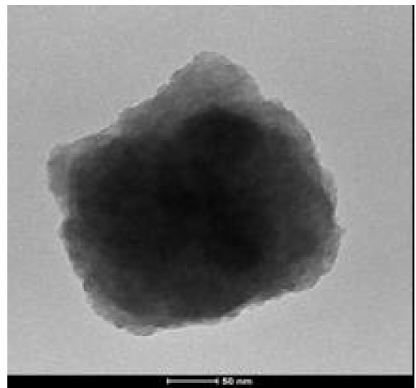
Figure 6. TEM micrograph of a tannic acid template mesoporous silica nanoparticle.